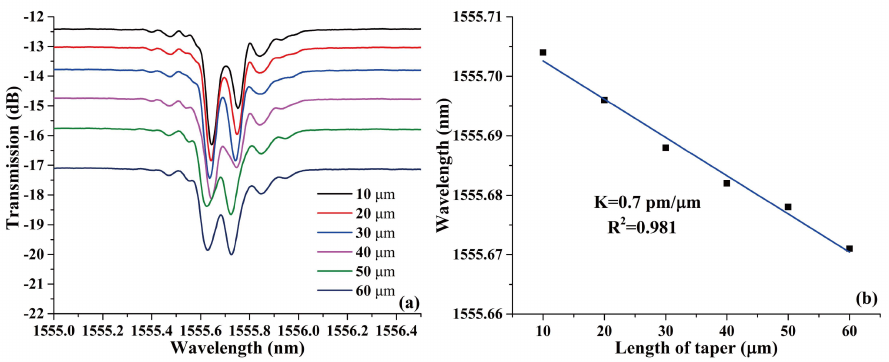
Figure 3. ( a ) The evolution of transmission spectrum versus the length of taper, and ( b ) the corresponding linear fit of the transmission window in